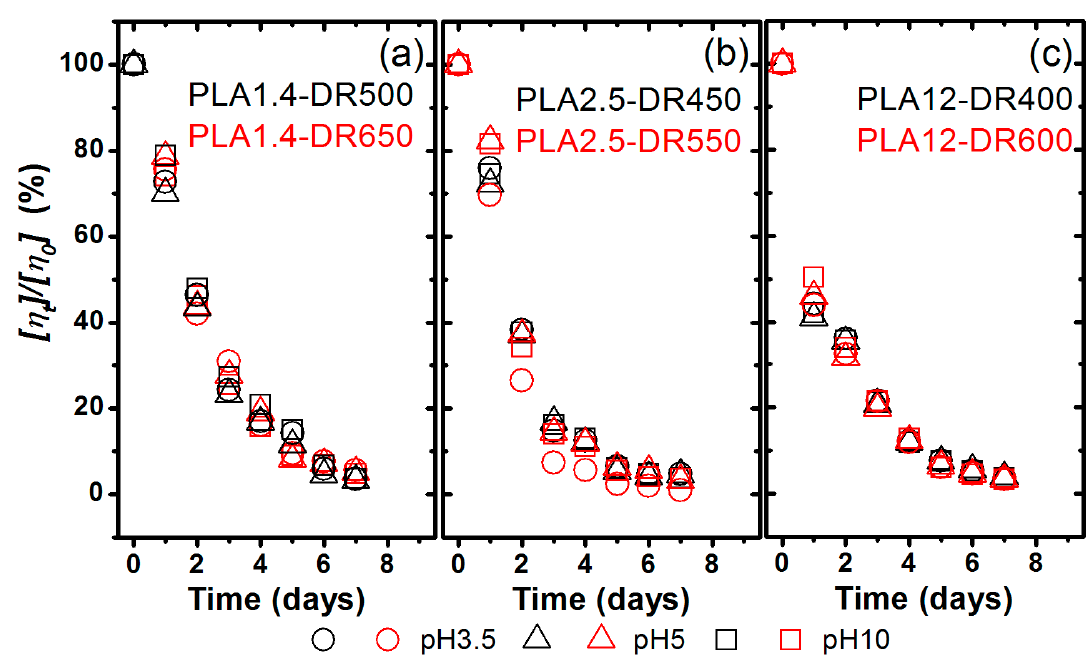
Figure 4. Changes of the intrinsic viscosity percent remaining of the studied samples during thermal-supported hydrolytic degradation: ( a ) fibres made from PLA Ingeo 6201D, ( b ) fibres made from PLA Ingeo 2002D, and ( c) fibres made from PLA Ingeo 4060D.